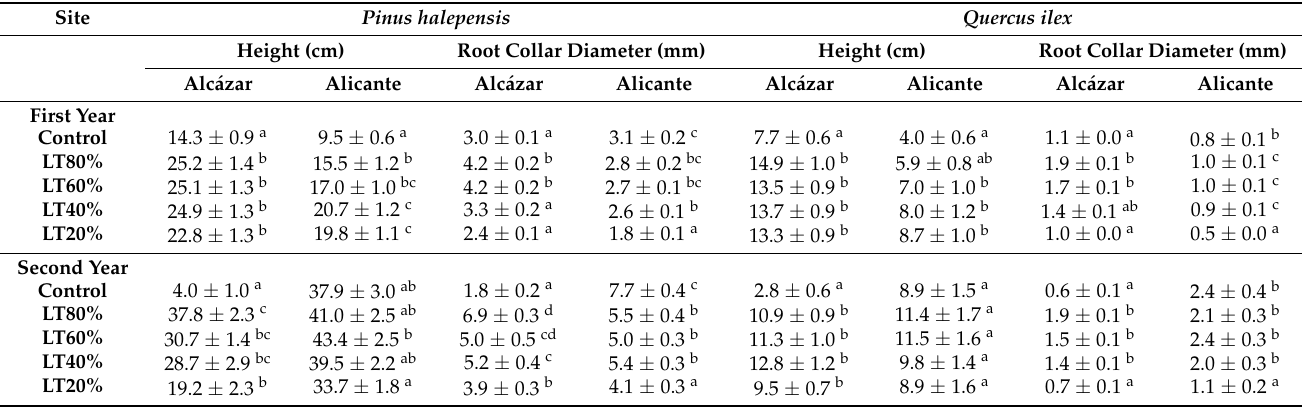
Table 3. Height and root collar diameter absolute growth (mean ± standard error; n = 50 for the first growing season and 35–45 for the second) for both species at the two sites during the first (November 2010) and second (November 2011) years after planting for the different shelter types (control mesh plus a gradient of wall light transmissivity ranging from 20 to 80% of incident radiation). Different letters following height or diameter denote distinct groups for each species, year, and site (Tukey, α = 0.05).